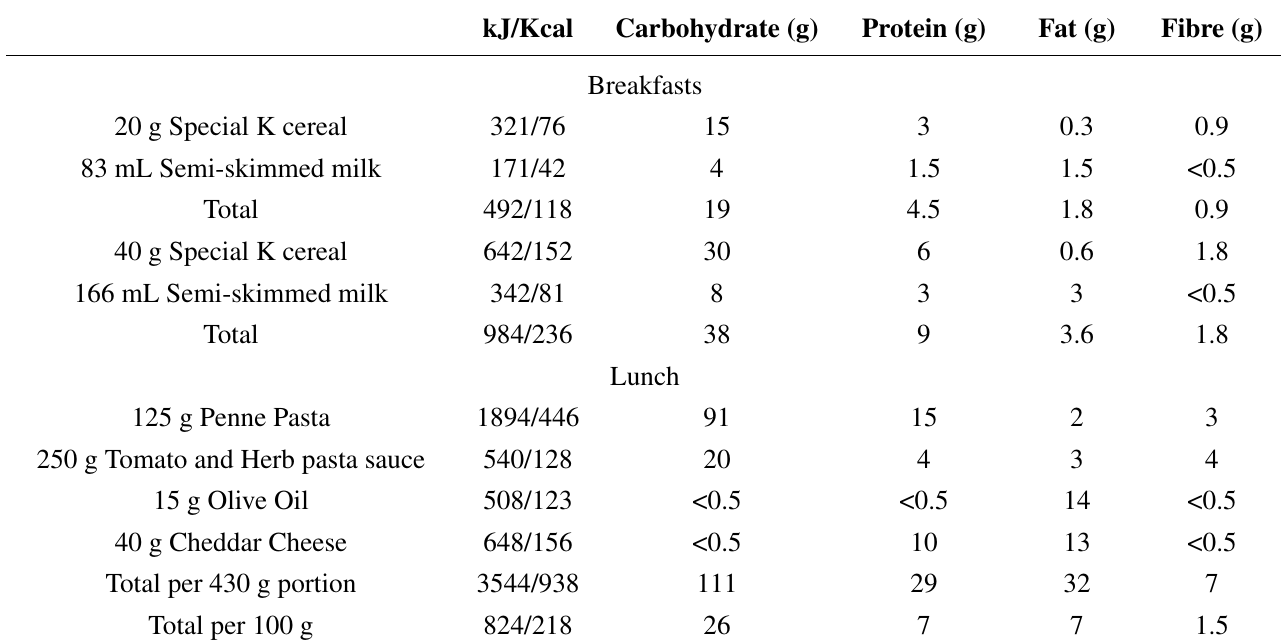
Table 1. Nutritional content of study